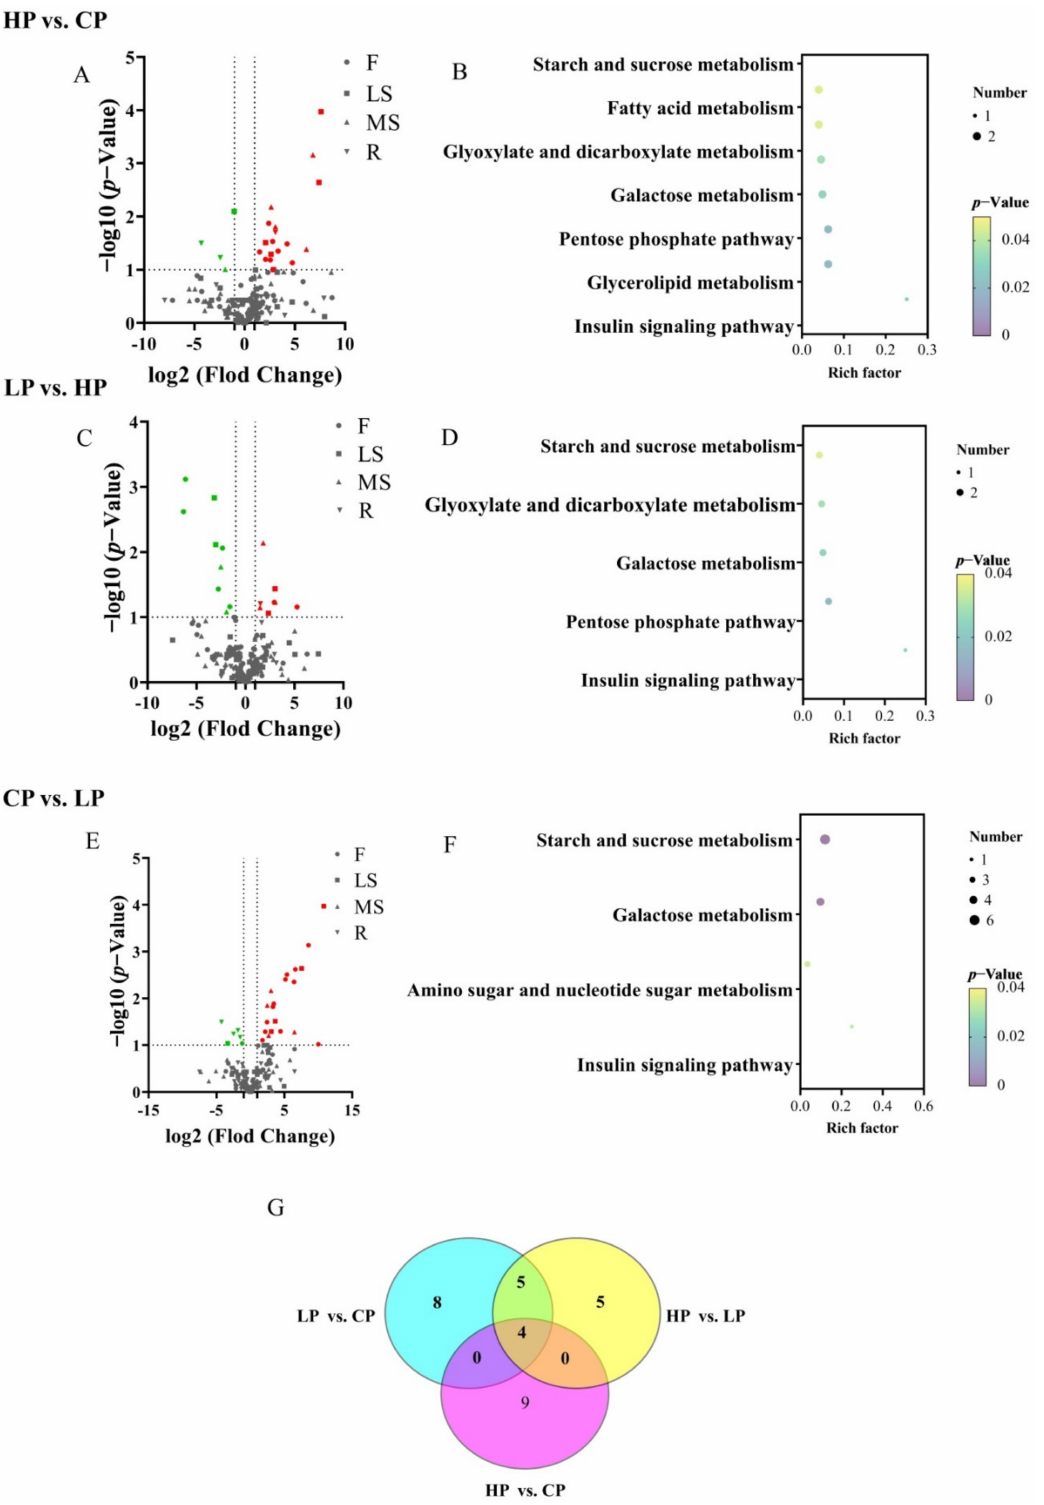
Figure 6. ( A – F ) The volcanic map of differential metabolites and enrichment analysis of KEGG. The red and green colors represent the content of metabolic that was up-regulated and down-regulated, respectively; • , (cid:110) , (cid:78) , (cid:72) represent flowers, lateral shoots, main shoots and roots, respectively. The p -value indicates the degree of enrichment, and the closer the p -value is to 0, the more remarkable the enrichment. The point stand for the quantity of differential metabolites. ( G ) The Venn diagram of differential